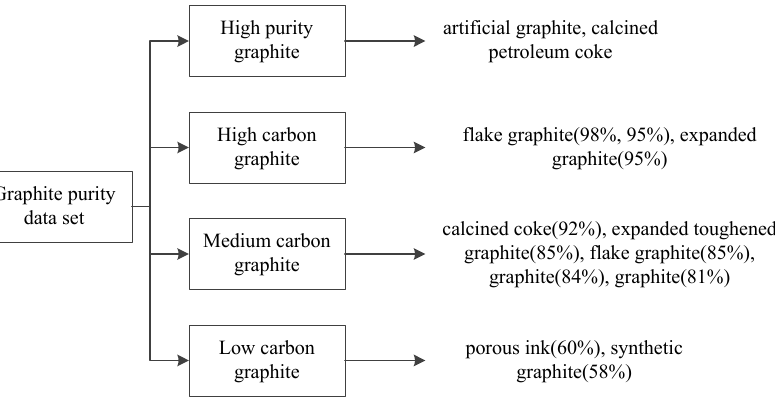
Figure 2. Graphite purity data set.